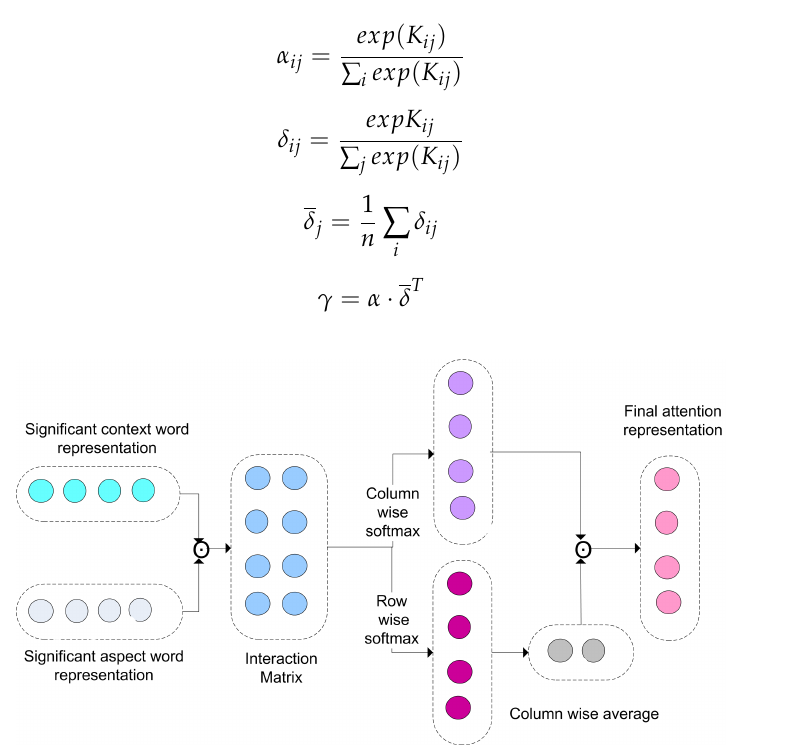
Figure 2. The interactive attention